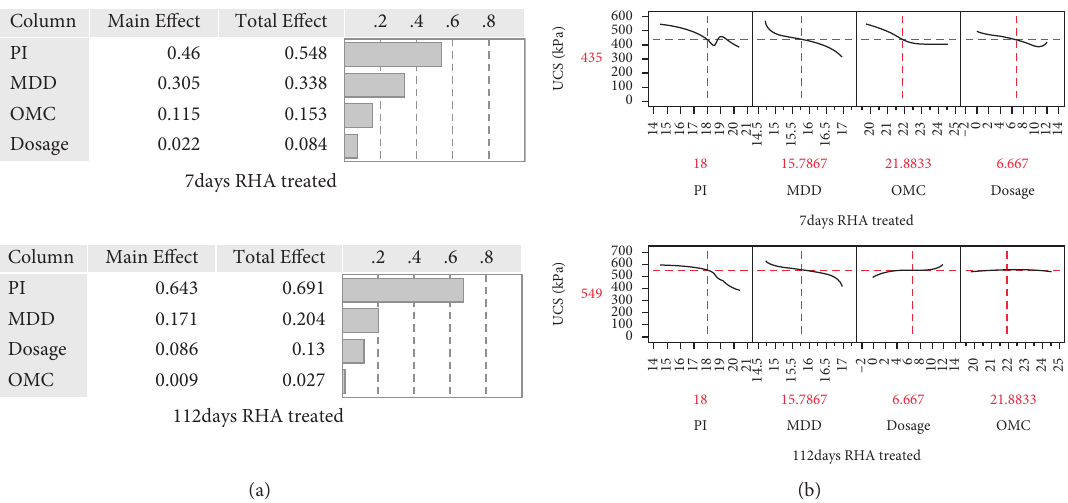
Figure 9: ANN-based sensitivity analyses: (a) variable order and magnitude of influence and (b) variable impact profiler for RHA-treated